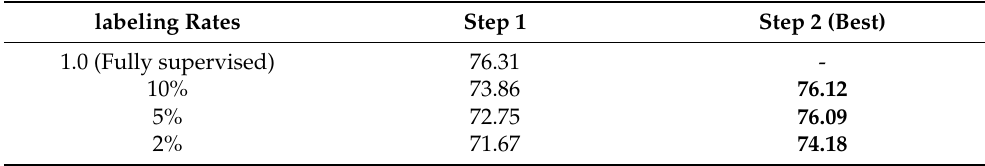
Figure 3. Visualization of the features of labeling rate 0.02 ( left ), 0.05 ( middle ) and 0.1 ( right ) on the test set by TSNE. Purple dots represent unlabeled images, yellow dots represent labeled low-quality images and green dots represent labeled high-quality images. Table 3. Accuracy (%) of experiments on different labeled